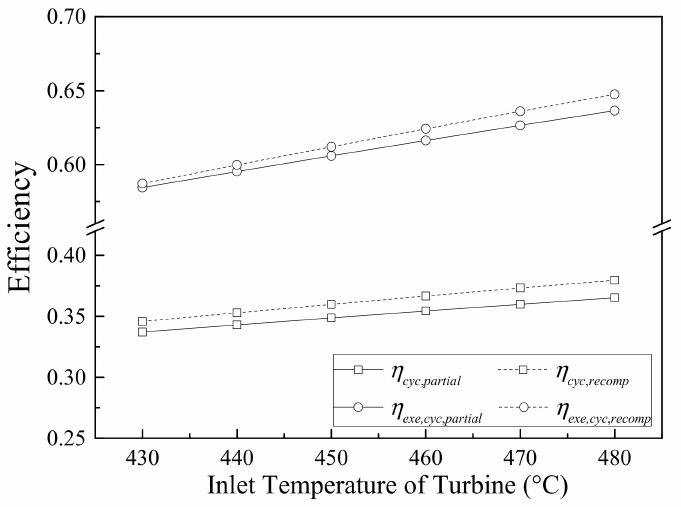
Figure 9. Effects of T max on η cyc and η exe , cyc with the partial-cooling cycle compared with the recompression